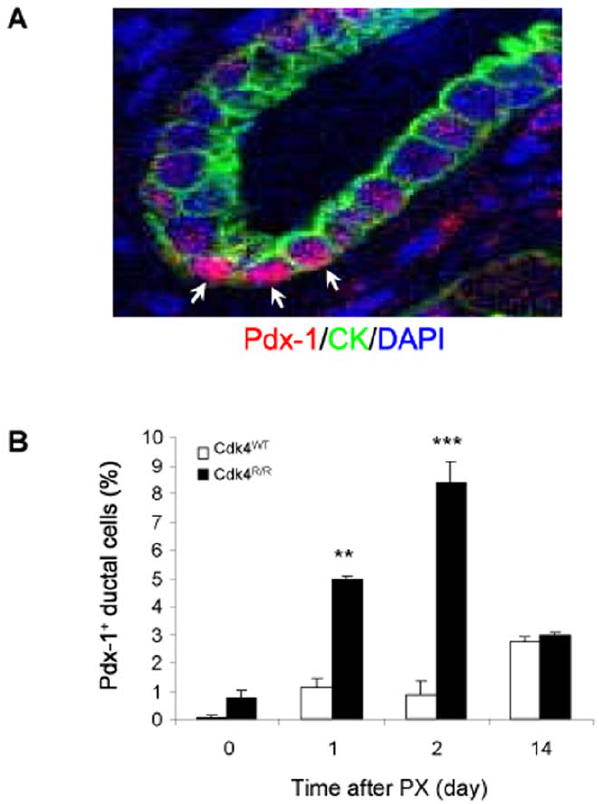
Figure 5. Pdx-1 expression in pancreatic ductal epithelial cells from Cdk4 R/R mice after pancreatectomy. (A) A representative picture of Pdx-1 expression observed within the cytokeratin (CK)- positive pancreatic ductal epithelium from Cdk4 R/R mice. Arrows show Pdx-1 + :CK + cells. Blue color identifies DAPI-stained nuclei. (B) Percent- age of Pdx-1 + ductal epithelial cells was significantly increased by 2 days post-PX in Cdk4 R/R mice (closed bars) compared with Cdk4 WT mice (open bars). Data are shown as means from four mice of each genotype per group and error bars represent S.E. ** p , 0.01, and *** p , 0.001 vs Cdk4 WT mice.